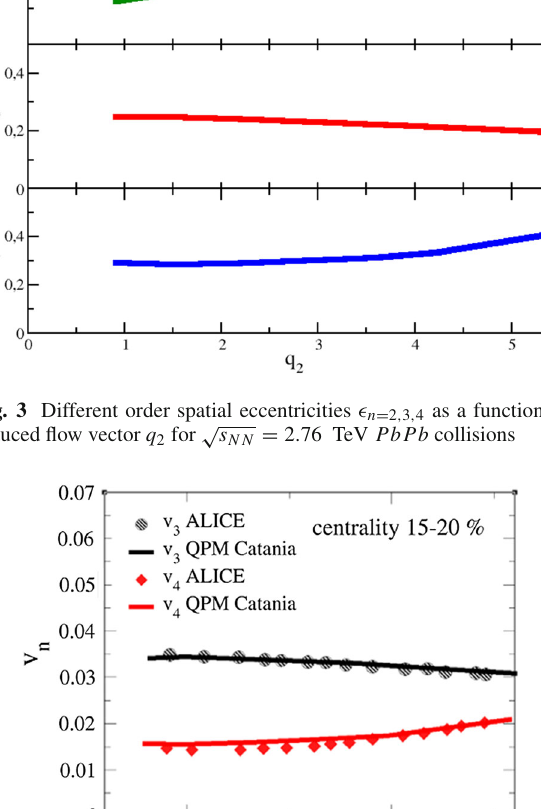
ing that the final state v 2 and v 3 are very well correlated with the second and third order eccentricities in the initial state, for small values of η/ s [40,60–62]. In Fig. 4 the cor- relations between v 2 and v 3 (solid black line), v 2 and v 4 (red solid line) for charged particles in PbPb collisions at √ s NN = 2 . 76 TeV in 15–20% centrality class are shown in comparison with the experimental data from ALICE Collab- oration [63]. In these calculations, for a given centrality class, every point is determined evaluating the v n varying the q 2